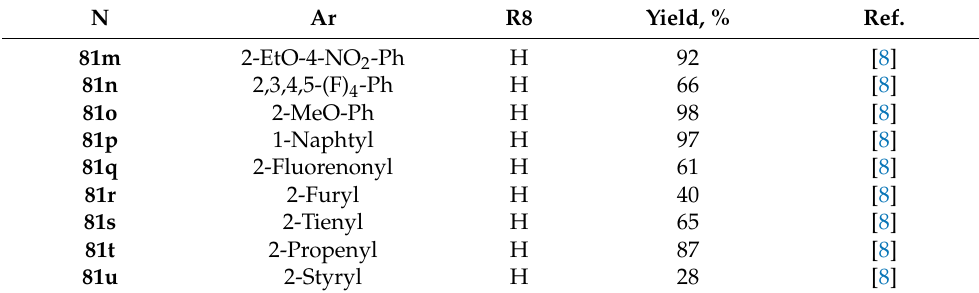
Table 21. Substituents and yields of the ring closure reaction on Scheme